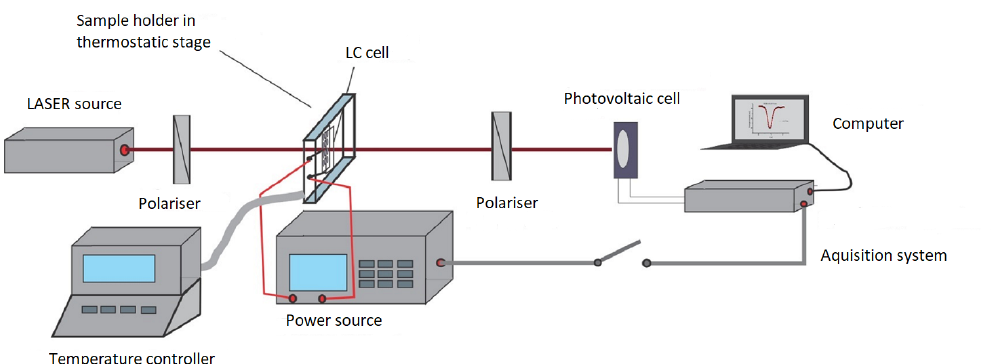
Figure 4. Experimental set-up for Freedericksz transition